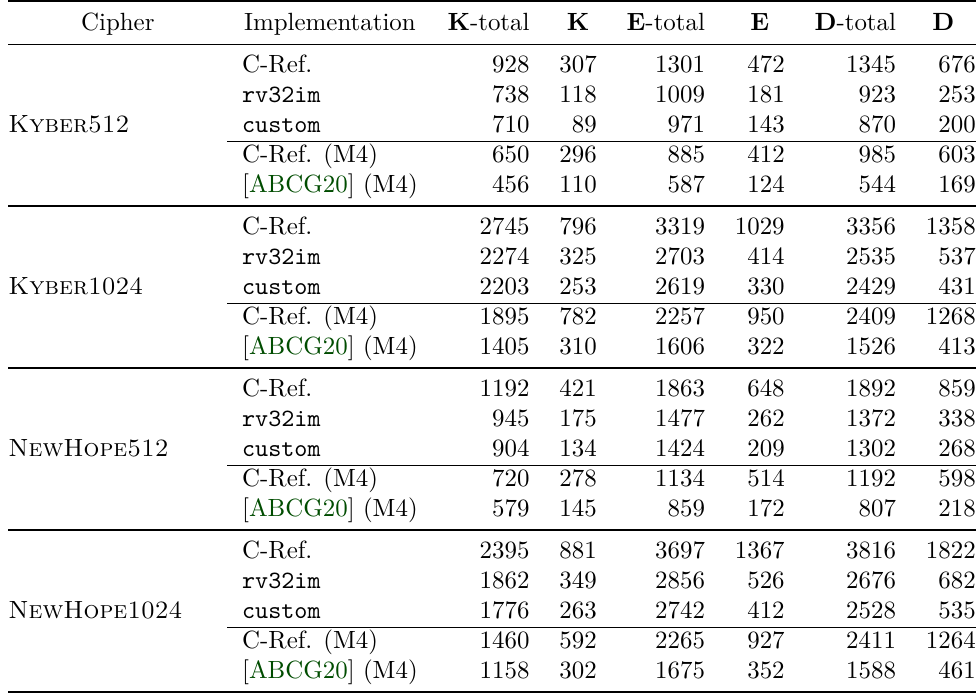
Table 4: Performance (in kilo cycles) of the cipher implementations for key generation ( K ), encapsulation ( E ), and decapsulation ( D ).